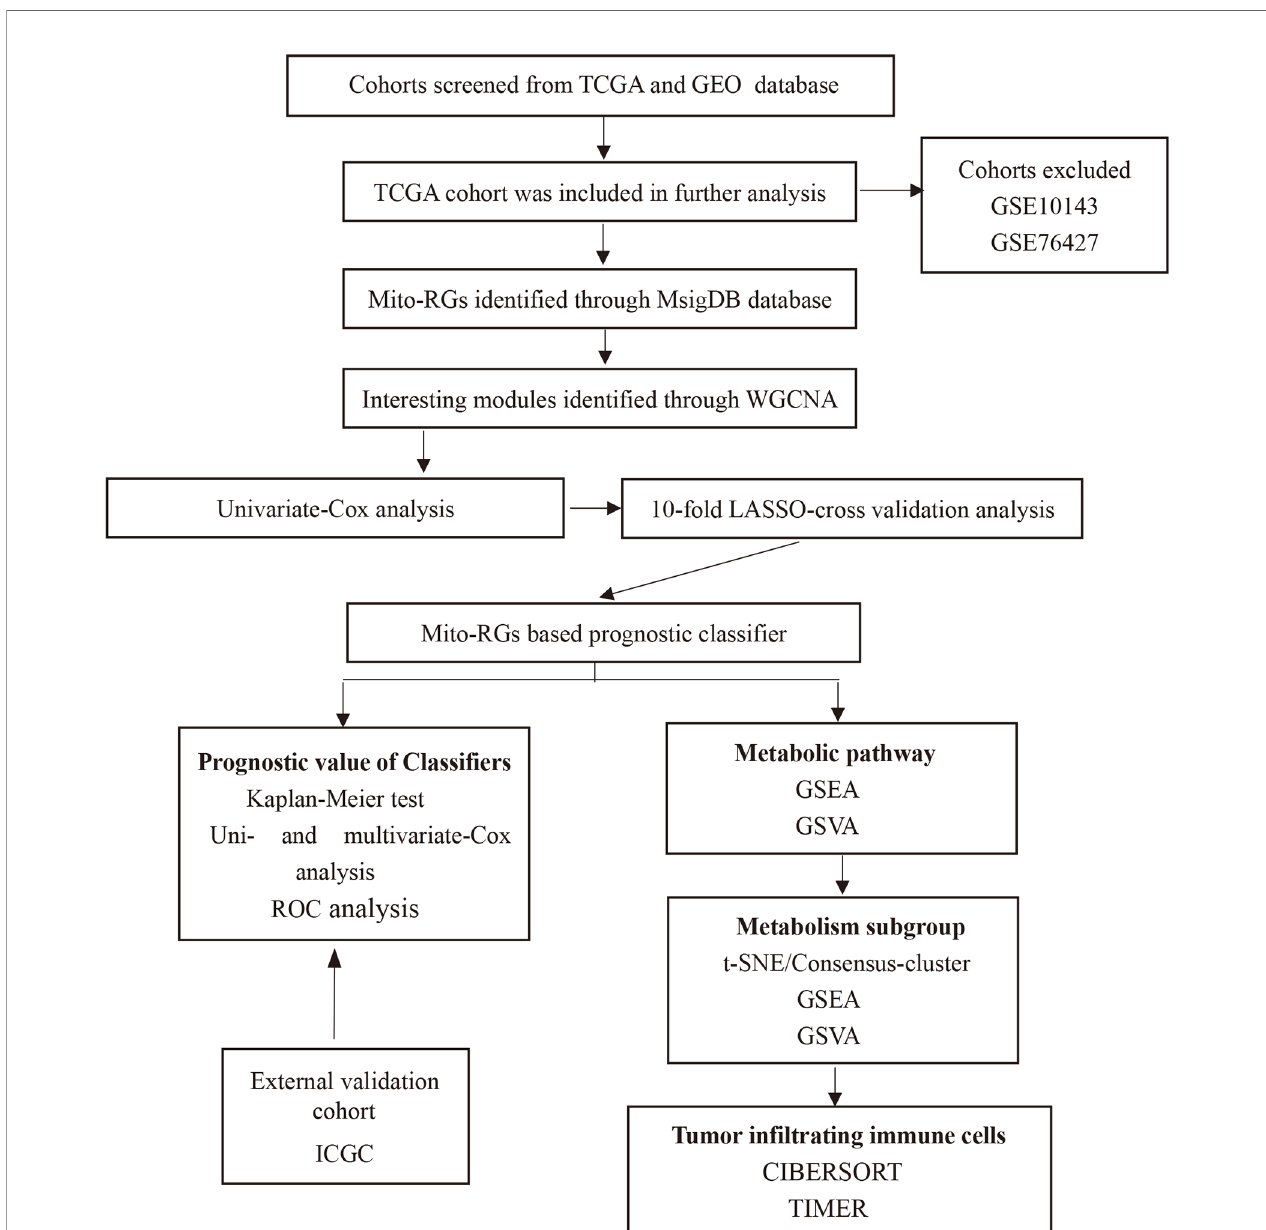
FIGURE 1 | Flowchart of the construction of the Mito-RGs-based prognostic classi fi er. Mito-RGs, mitochondrial-related genes; ROC, receiver operating characteristic; WGCNA, weighted gene co-expression network analysis; TCGA, The Cancer Genome Atlas; LASSO, The least absolute shrinkage and selection operation; GSVA, Gene set variation analysis; GSEA, Gene set enrichment